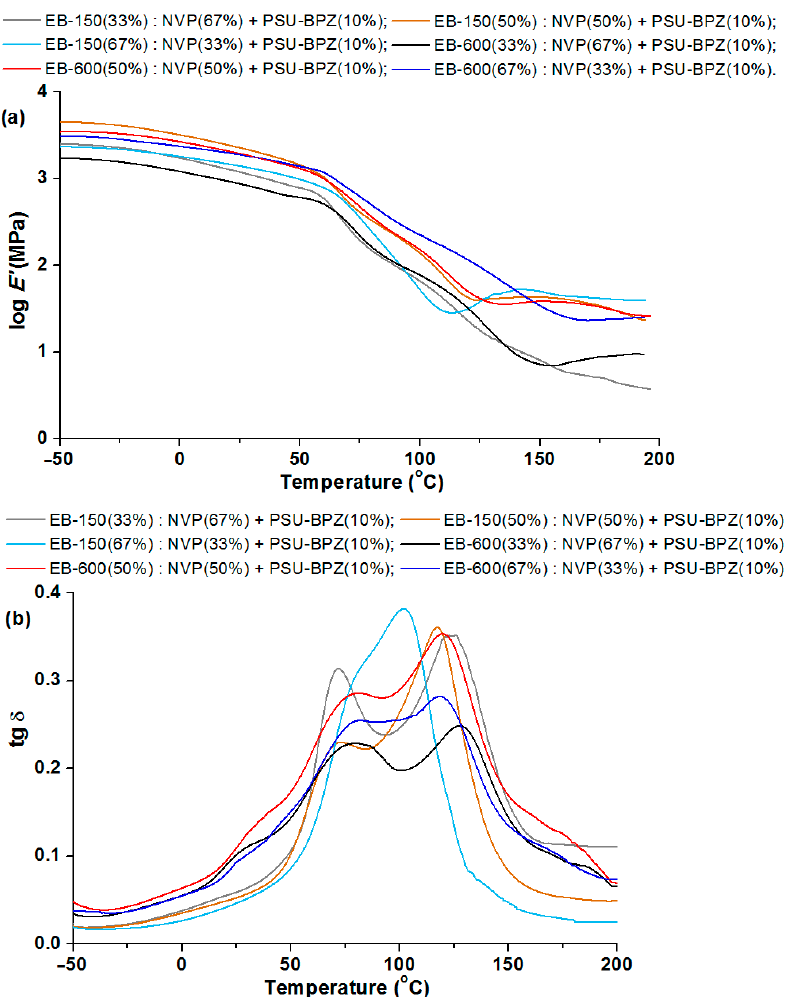
Figure 14. DMA analysis of polymeric blends with 5 wt.% of dopant: ( a ) storage modulus and ( b ) tangent delta in the function of temperature.